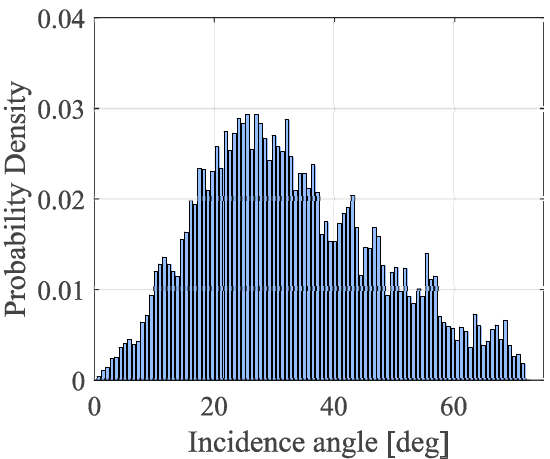
Figure 10. The empirical probability density for CYGNSS incidence angles during the whole month of April 2019 over the study area.